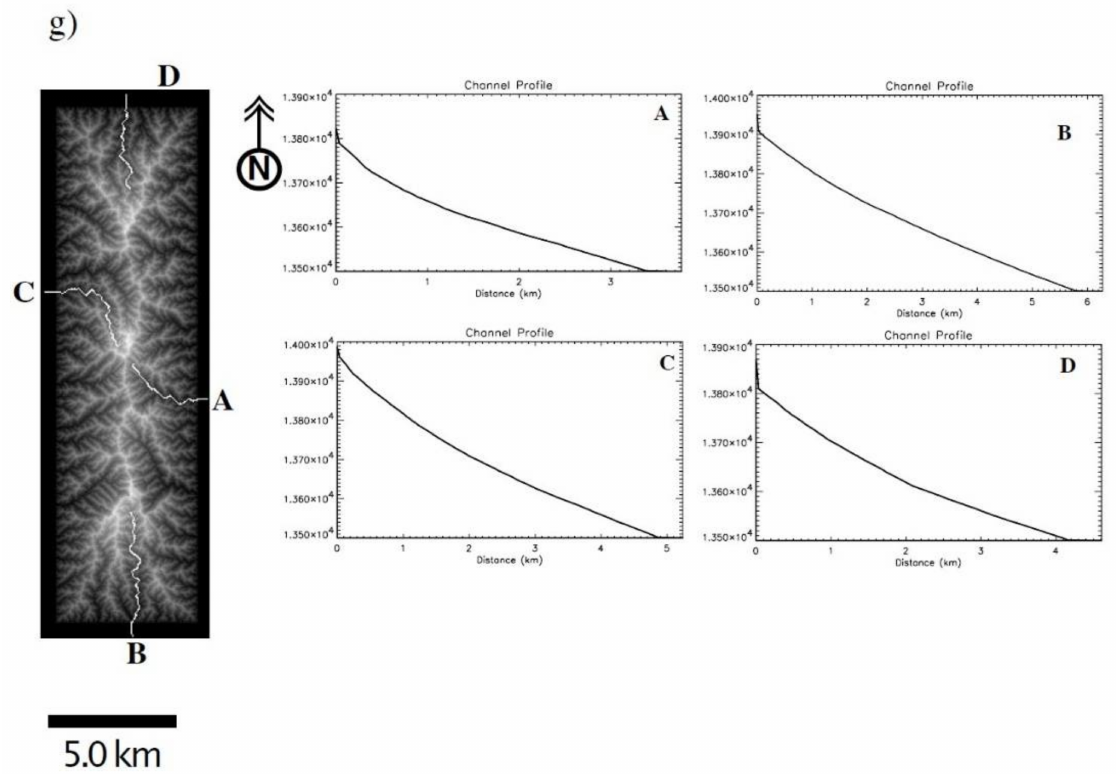
Figure 5. ( a – f ) Evolution of the upper surface of a simple uplifting structure over 1 Ma, and ( g ) illustration of final stream profiles indicated (vertical exaggeration